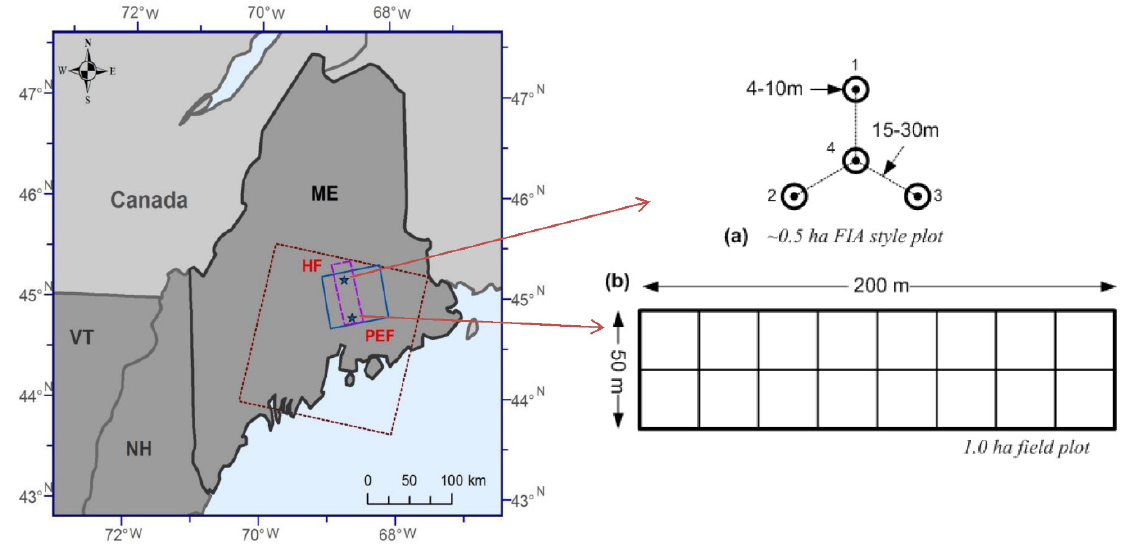
Figure 1. Map of study sites, and coverage of Landsat ETM+ scene (red dashed line, p011/r029), ALOS PALSAR FBD scene (blue solid line), and PLR scene (purple dashed line). ( a ) FIA style plot, and ( b ) 1.0 ha field